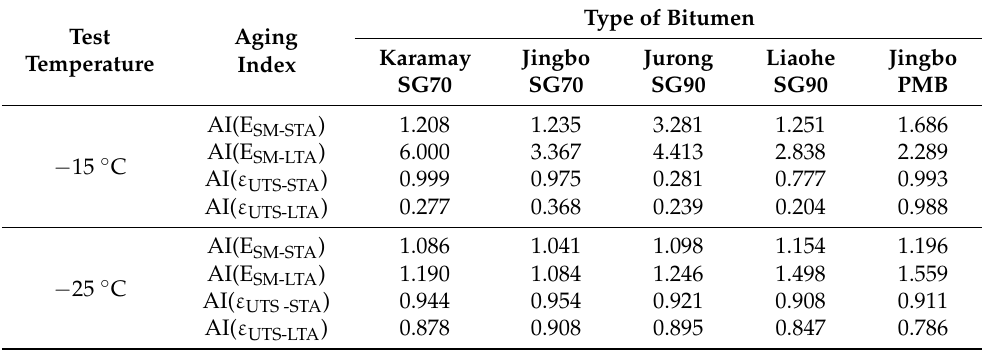
Table 12. The aging indexes determined by the relative change in the stiffness modulus and ultimate tensile